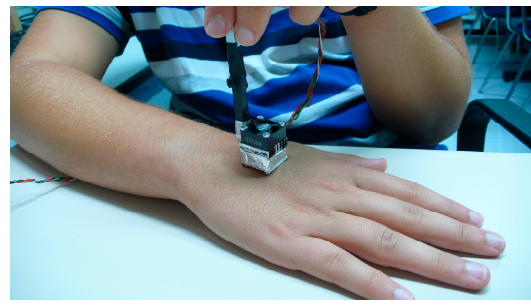
Figure 4. Calorimetry minisensor on the right hand of the subject.